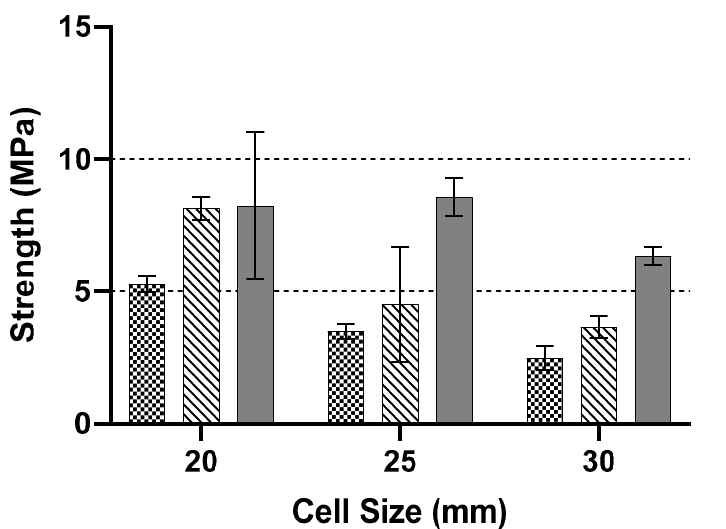
Figure 10. Comparison between constant cell sizes with variable thickness.